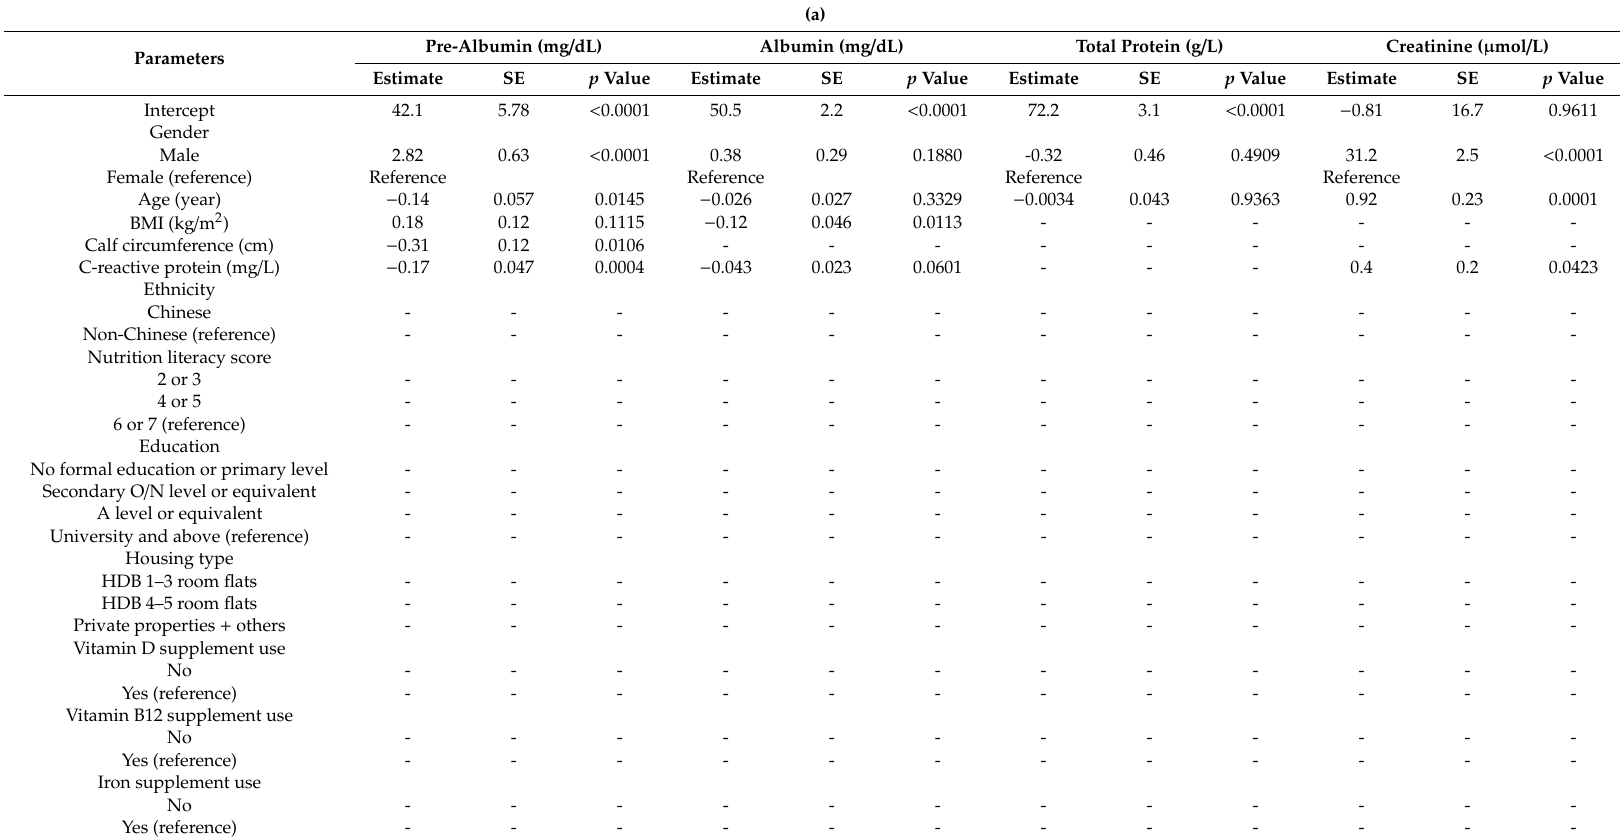
Table 5. Factors associated with nutritional